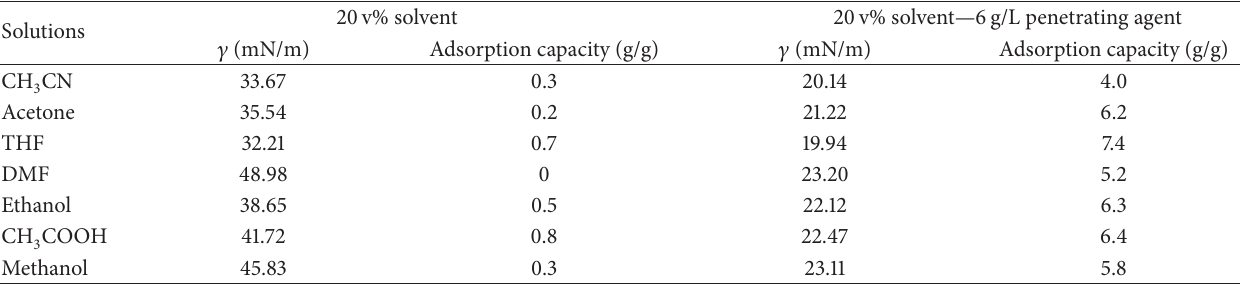
Table 4: The adsorption capacities of 20v% solvent solutions in water in different surface